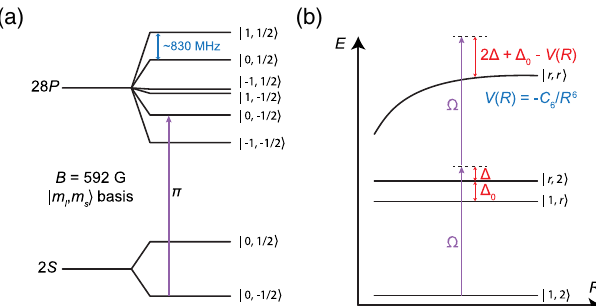
FIG. 7. Rydberg dressing of 6 Li. (a) Level diagram showing the hyperfine ground states of 6 Li directly coupled to the 28 P Rydberg state using linearly ( π ) polarized light at a field of ; m 592-G. The basis we use is j m . (b) Rydberg-dressing l s i scheme for two atoms in different hyperfine ground states j 1 i and j 2 i coupled to the Rydberg state j r i . Ω is the Rabi coupling of the laser, Δ is the detuning from the resonant transition between j 1 i and j r i , Δ 0 is the hyperfine splitting between j 1 i and j 2 i , and V ð R Þ ¼ − C 6 =R 6 is the van der Waals interaction potential between two Rydberg states j r i